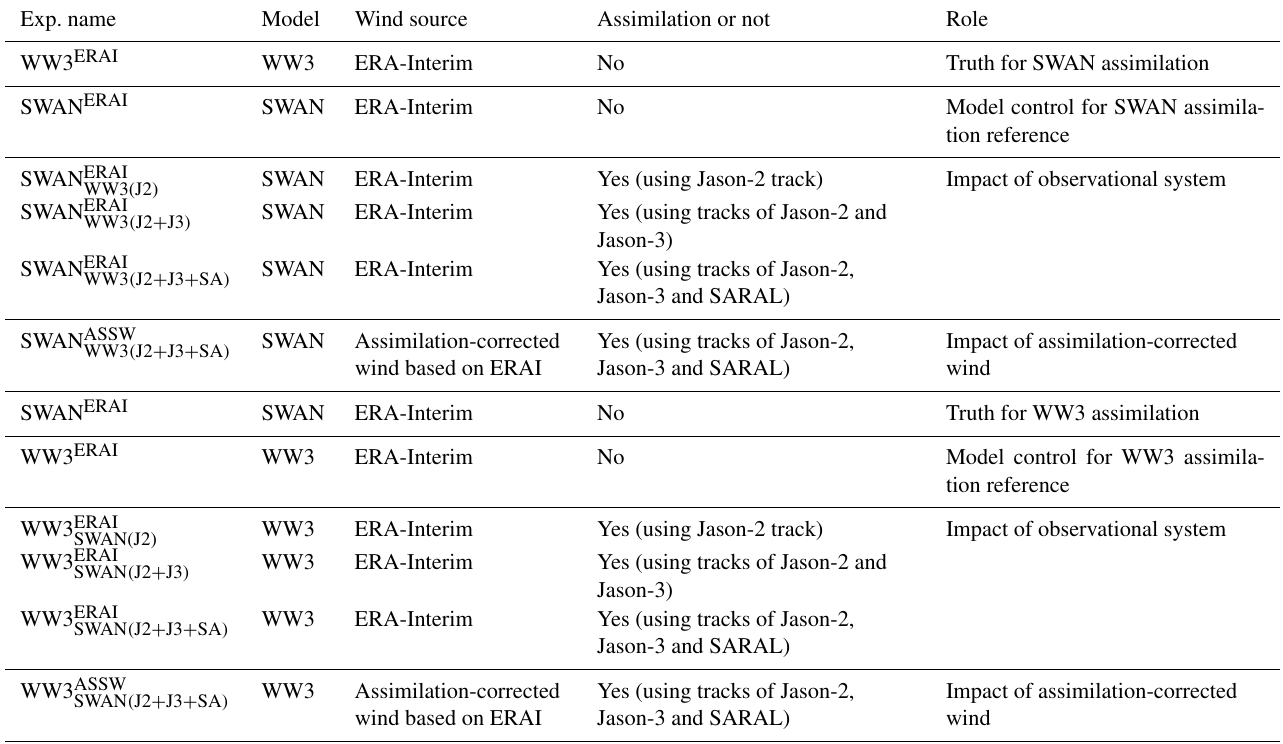
Table 2. List of biased model twin experiments. Exp.